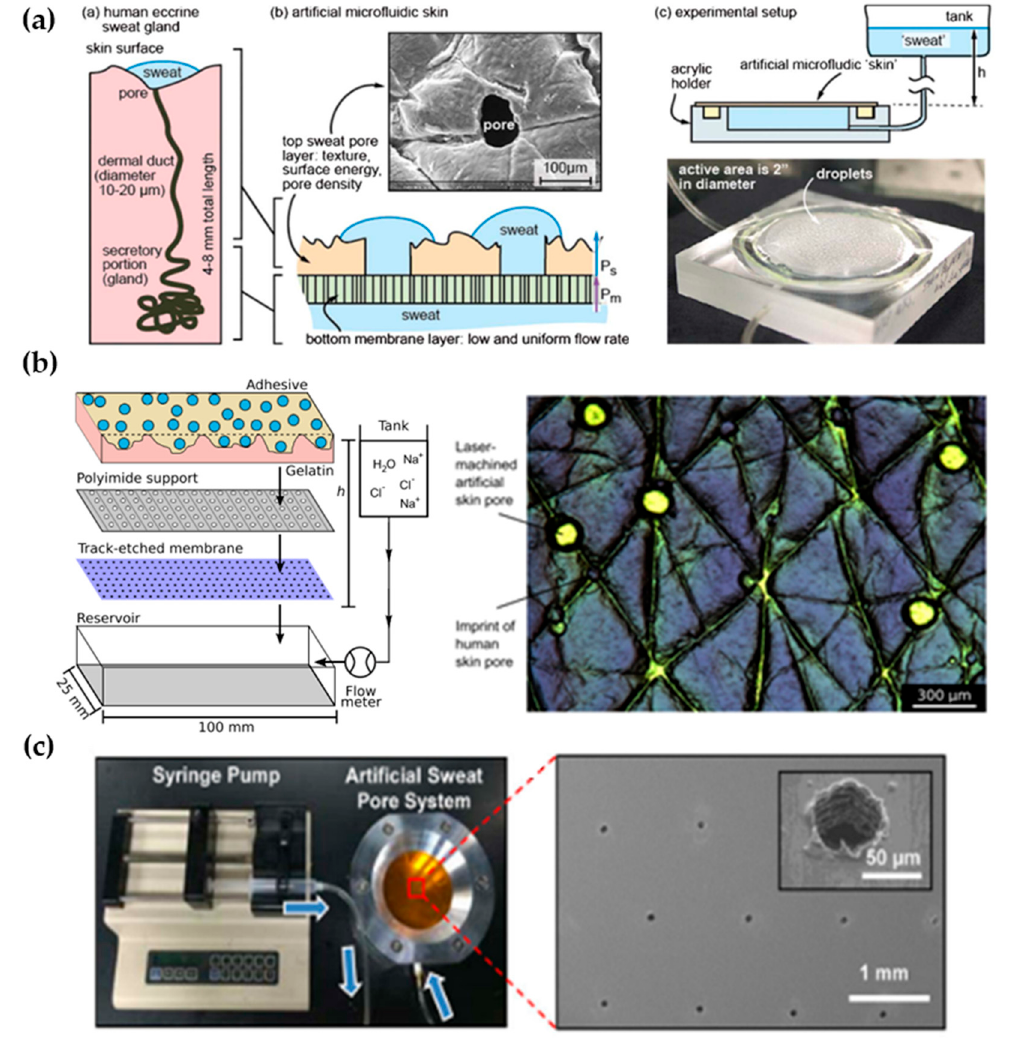
Figure 3. Perspiration models in literature. ( a ) Schematic of the bi-layer membrane design and its comparison with the sweat gland structure (left). Depiction of the experimental set-up and image of the integrated membrane (right). Reprinted with permission from [34]. Copyright 2013, Royal Society of Chemistry. ( b ) Scheme showing the layers of the perspiration model by Hansen et al. [45] (left). Adapted with permission from [45]. Copyright 2020, American Chemical Society. Microscopy image of the surface of the artificial skin by Eiler et al. [46] (right). Adapted with permission from [46]. Copyright 2020, Elsevier. ( c ) Experimental set-up of the artificial sweat pore system used by Koh et al. [45] and SEM image of the perforated membrane. Reprinted with permission from [45]. Copyright 2016, The American Association for the Advancement of Science.